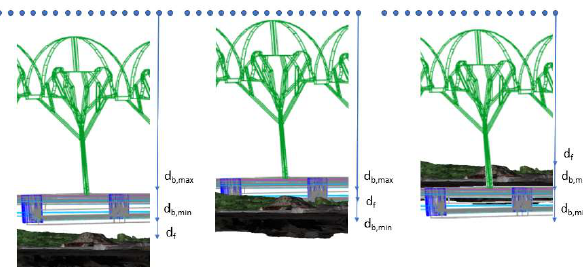
Figure 8: The three options for as-built vs as-design, the as-built is beneath the as-design (left), the as-built is between the top and bottom of the as-design (middle) and the as-built is above the as-design model (right).